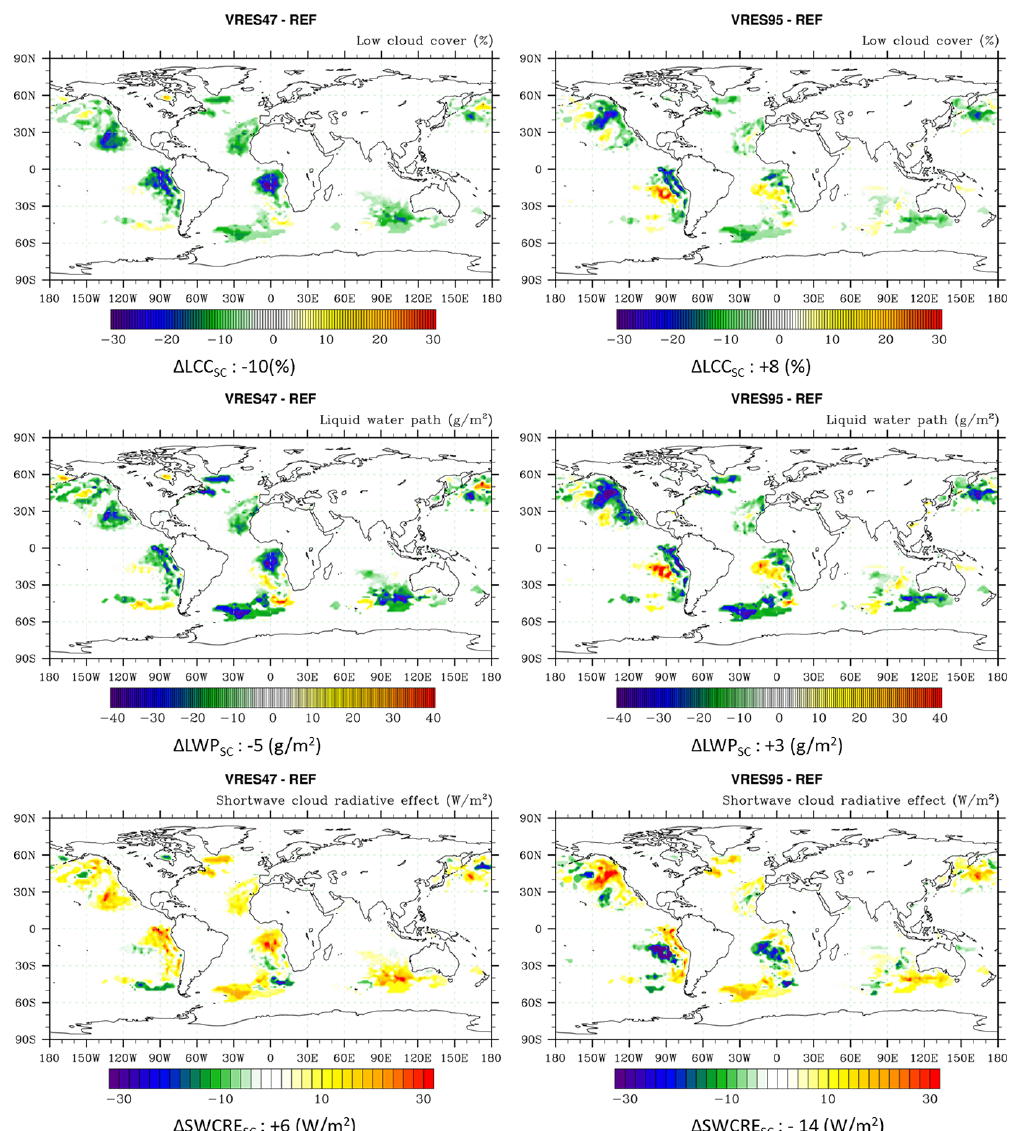
Figure 12. Same as in Fig. 10 but for increased vertical resolution (L47bl and L95bl). Values below each panel are in-regime